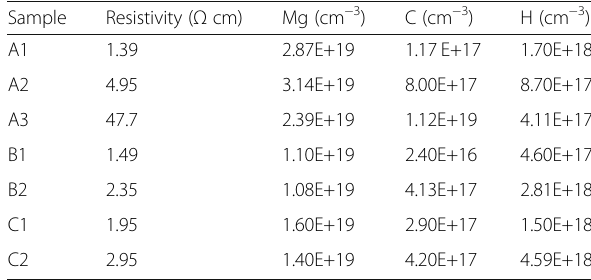
Table 1 Resistivity and Mg, C, H, and O concentrations for Mg- doped p-GaN samples